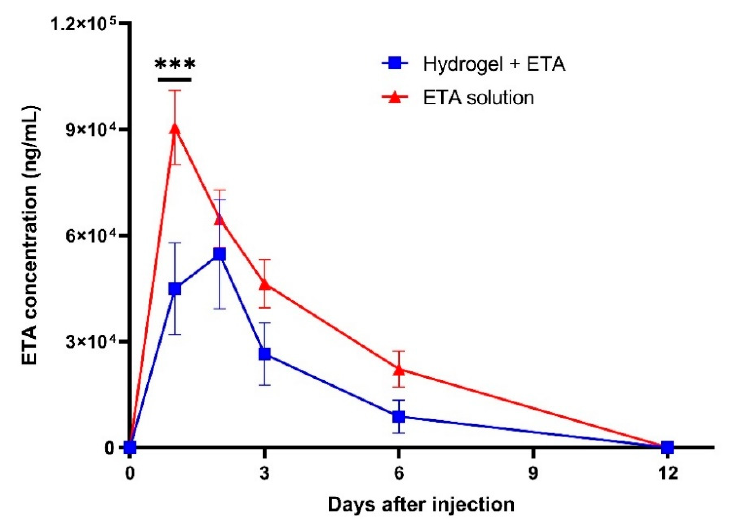
Figure 4. In vivo ETA release profiles. The red and blue curves represent the ETA solution and the hydrogel + ETA, respectively, injected in the knee joint of mice with OA. The error bars represent mean ± SD ( n = 6). Statistical significance was determined by two-way ANOVA with multiple comparisons; *** p < 0.001.